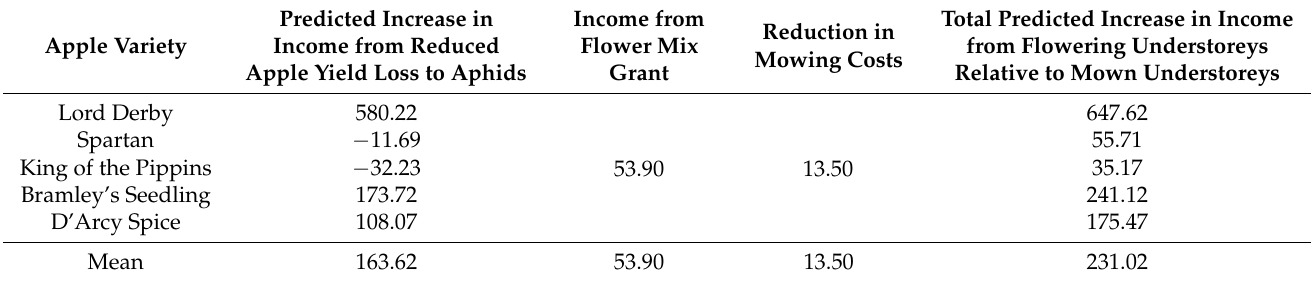
Table 5. Predicted changes in income (GBP/ha of agroforestry) arising from using a flowering understorey relative to a mown understorey. Positive values represent higher income (or less cost) from using the flowering understorey. Flower mix grants are for Countryside Stewardship AB8. The ‘Spartan’ block results should be interpreted with caution, because aphid damage was very low